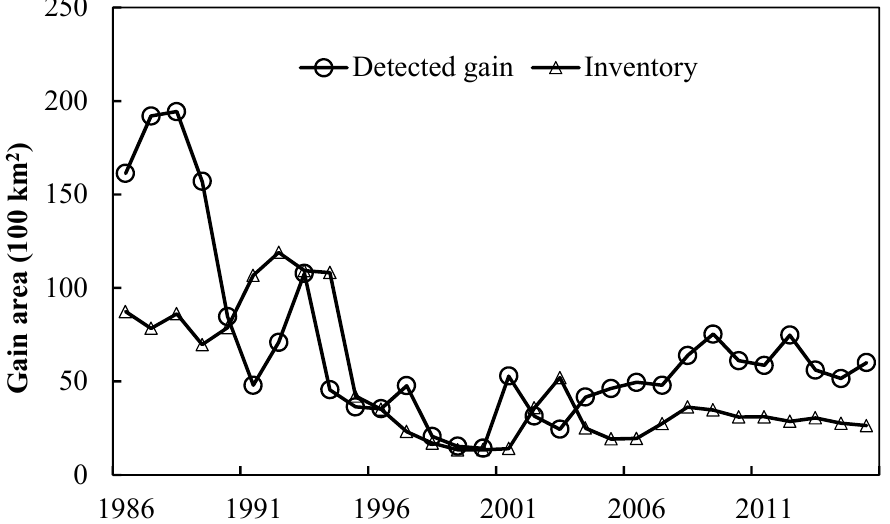
Figure 15. Comparisons of our estimated total forest gain area (100 km 2 ) with the NFI recorded planted forest area (https://forest.ckcest.cn/sd/si/zgslzy.html; accessed on 1 February 2022) in three provinces during 1986 – 2015.